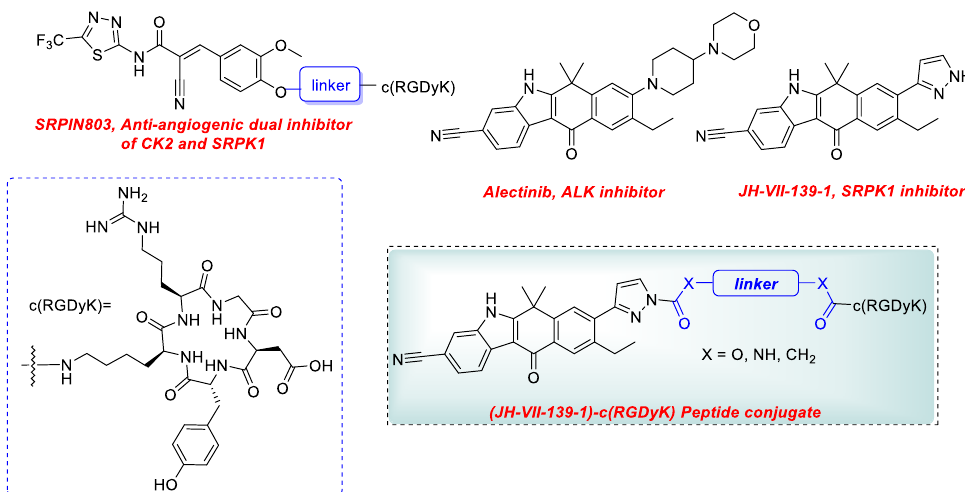
Figure 1. General structures of alectinib, JH-VII-139-1 and c(RGDyK) peptide conjugates that carry an SRPK1 inhibitor. an SRPK1